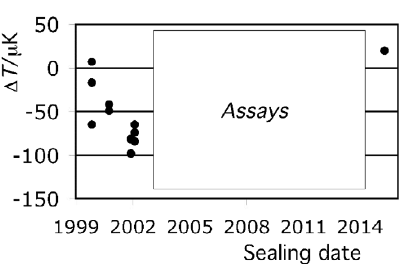
Fig. 3. Differences between samples drawn at INRIM at different times (from left to right) from the same bottle; zero of D T arbitrary, hydrostatic head correction applied. Sealing dates of INRIM cells: from left, cell 12Ne – 15Ne; cell E2 – E4Ne; cell Ec1Ne; cell Ec2Ne; cell Ec29Ne sealed and measured in 2015. Uncertainty of each determination is± ≈ 50 m K.